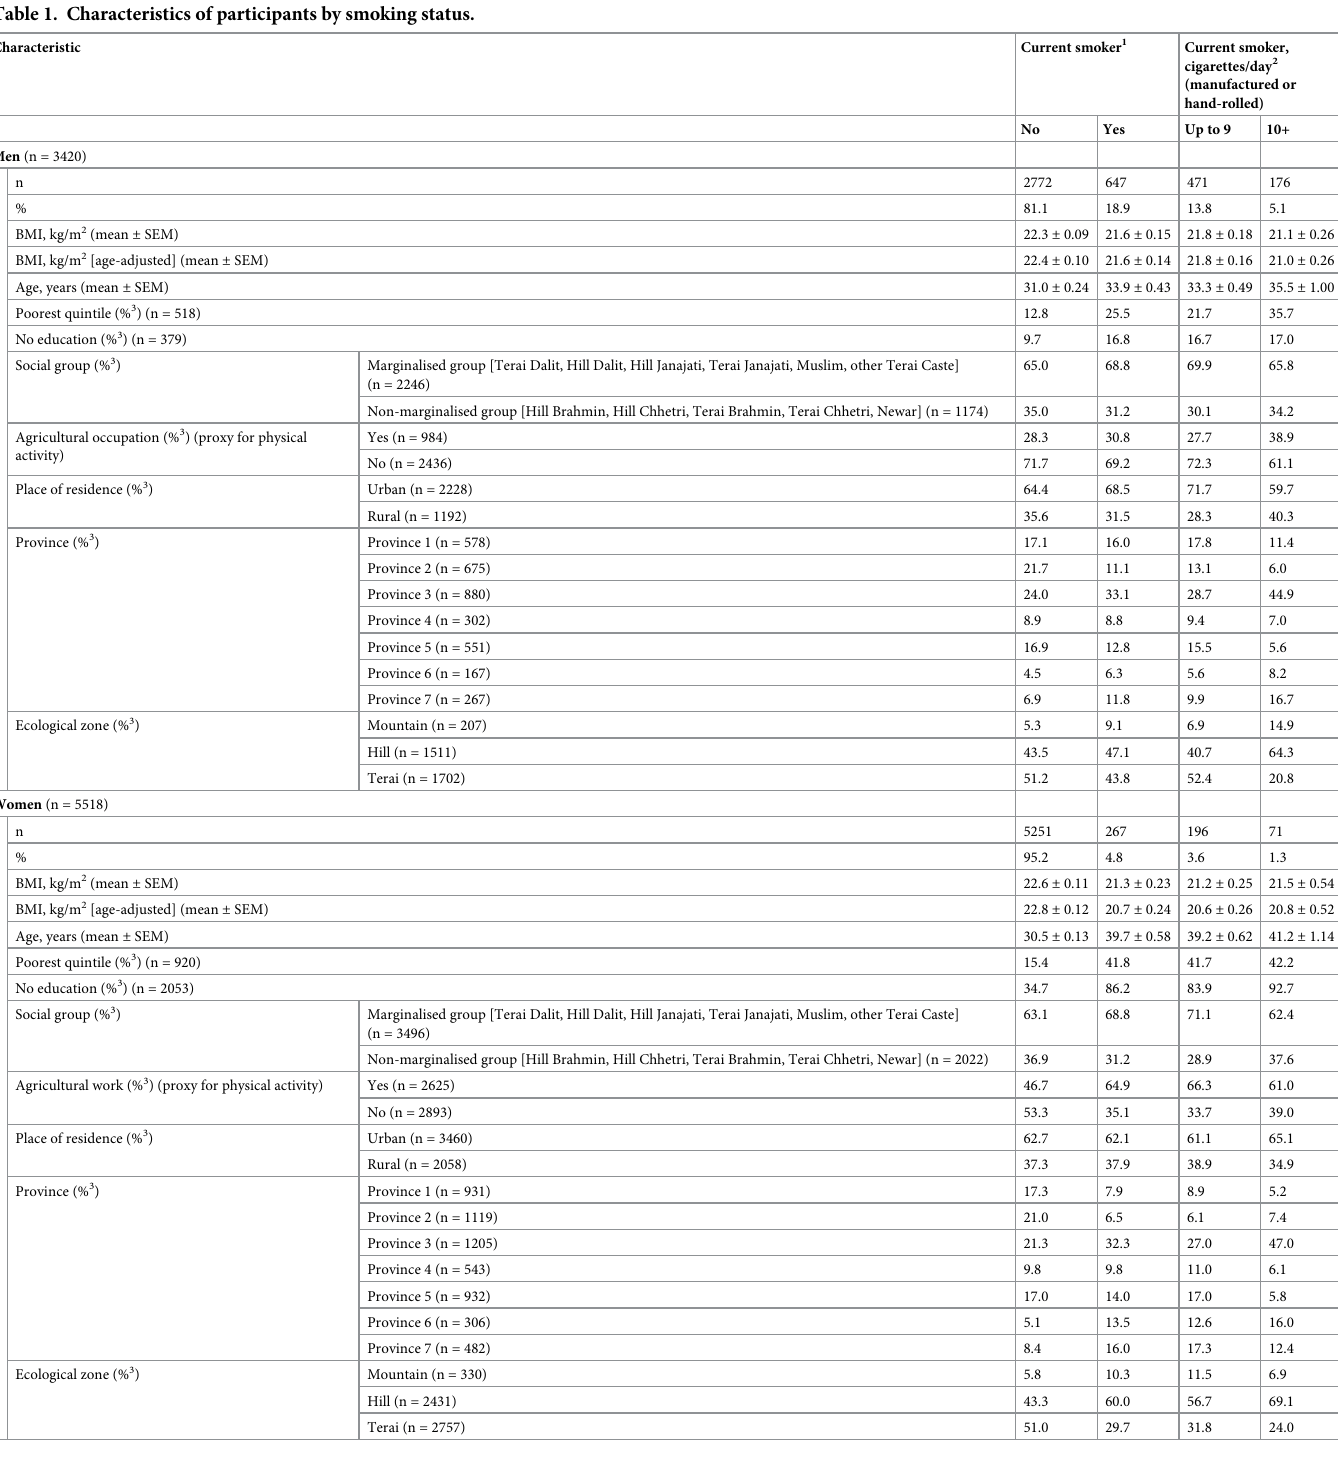
Table 1. Characteristics of participants by smoking status. Characteristic Currentsmoker